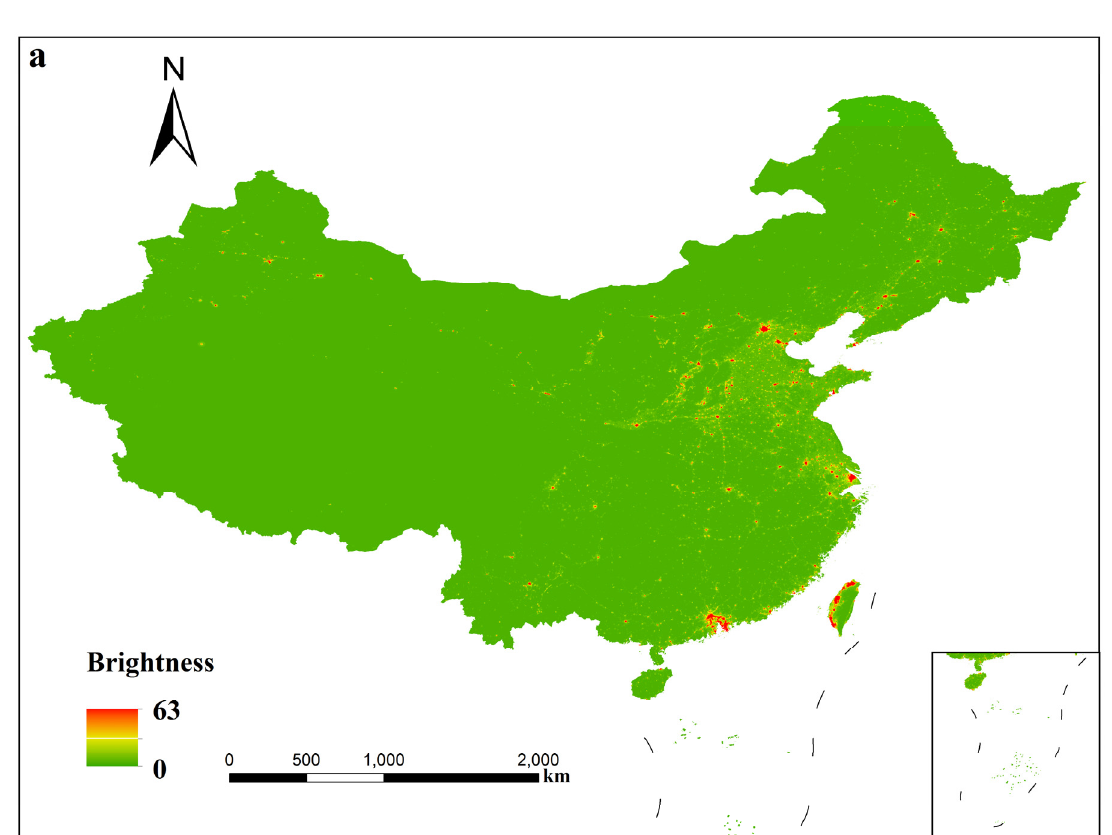
Figure 3. Pixel brightness (calibrated digital number) mean value 1992–1996 ( a ), 2000–2004 ( b ) and 2008–2012 ( c